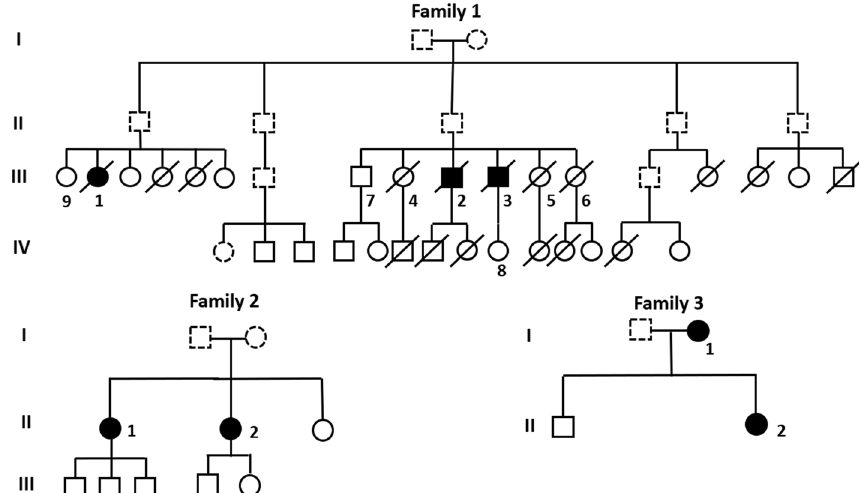
Fig. 1 Pedigrees of 3 FTN families. Pedigrees of 3 TN families are shown. Squares indicate male family members and circles indicate female family members. A solid black circle or square denotes the diagnosis of TN. Roman numerals denote generations. The soulid line indicates that blood samples were collected and Sanger sequencing was performed, and the dotted line indicates that blood samples could not be collected for various reasons, such as death. Arrows indicate the confirmed MARS1 mutation (c.2398C > A) by Sanger sequencing. In Family 3, II-2, the proband, had a MARS mutation (c.2104C > T). The subject in Family 1 marked with numbers shows the result of Sanger sequencing, which is shown in Fig.